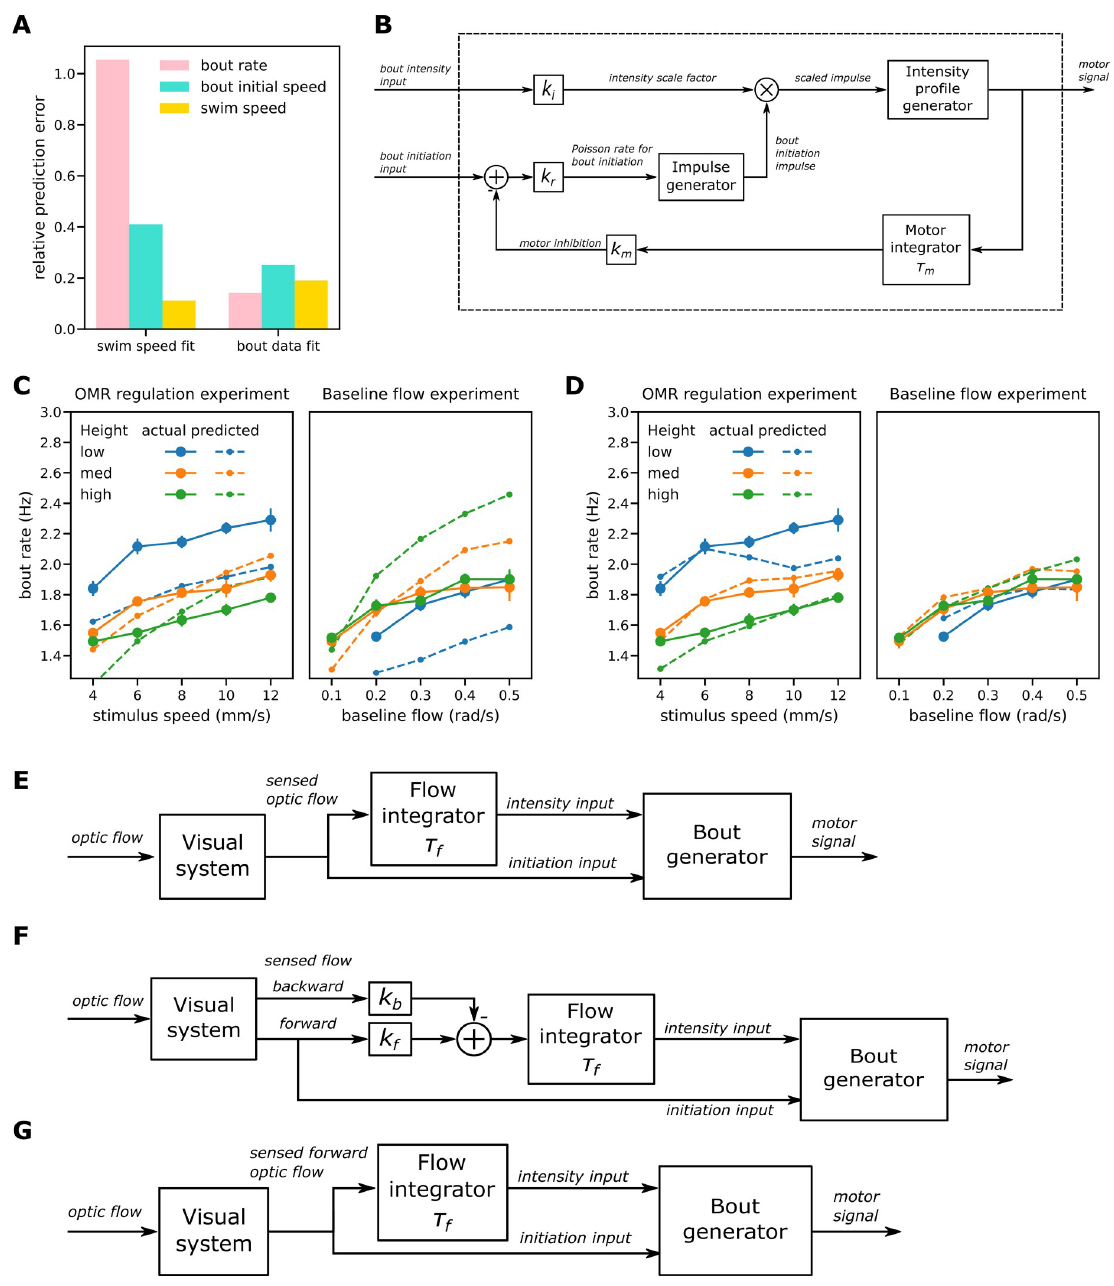
Fig 5. Modeling II: enhanced bout generation and two-factor model. (A) Mean prediction errors for the single factor model fitted to mean swim speed (left group of bars) and to bout measures (mean bout rate and intensity) (right group). Fitting to swim speed failed to predict the bout measures; fitting to bout data reduced prediction errors for bout measures but produced less accurate swim speed predictions. (B) Enhanced bout generator has separate inputs for bout intensity and bout initiation and the latter is subject to motor inhibition. (C) Bout rates for the single factor model fitted to bout measures. The model failed to predict that bout rates are sensitive to height in the OMR regulation procedure (left) but not the baseline flow one (right). (D) Bout rates predicted by the enhanced bout generator when fitted to bout data and constrained to reproduce the observed bout intensities. It was now possible to reproduce the bout rate patterns observed in the two experiments. (E-G) Dual factor model variants. Each variant has an enhanced bout generator with separate bout intensity and initiation inputs. Optic flow is integrated only for the intensity input. (E) Variant A: the overall optic flow is integrated. (F) Variant B: input to the flow integrator is a linear combination of the forward and backward components of optic flow. (G) Variant C: only the forward component of the optic flow participates in control of the translational